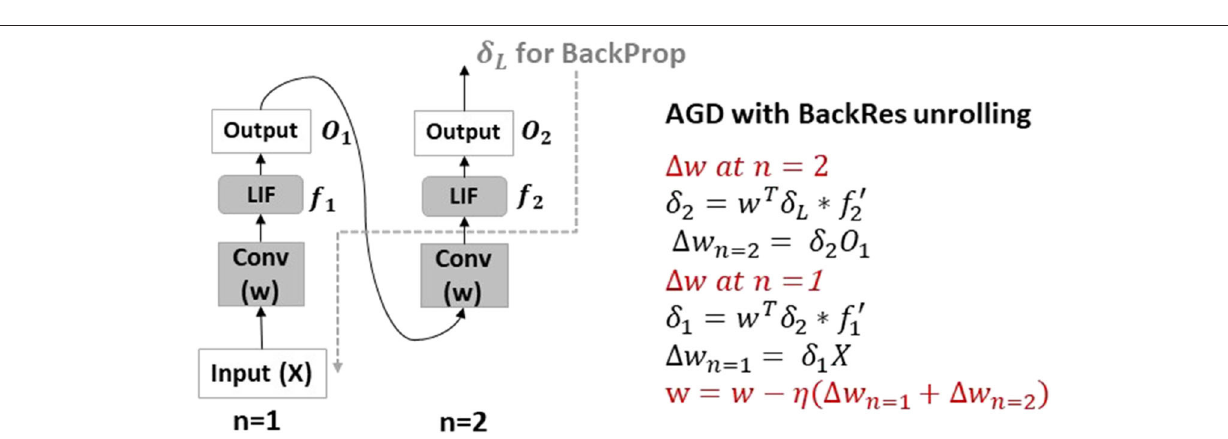
FIGURE 5 | AGD backpropagation chain rule update with BackRes connections. The BackRes block is essentially unrolled n times and the loss is propagated through the unrolled graph to compute the weight updates at each unrolling step n = 1,2 as shown. Note, the Conv layer weights w of the BackRes block receive two updates with different input and output combinations giving rise to diverse